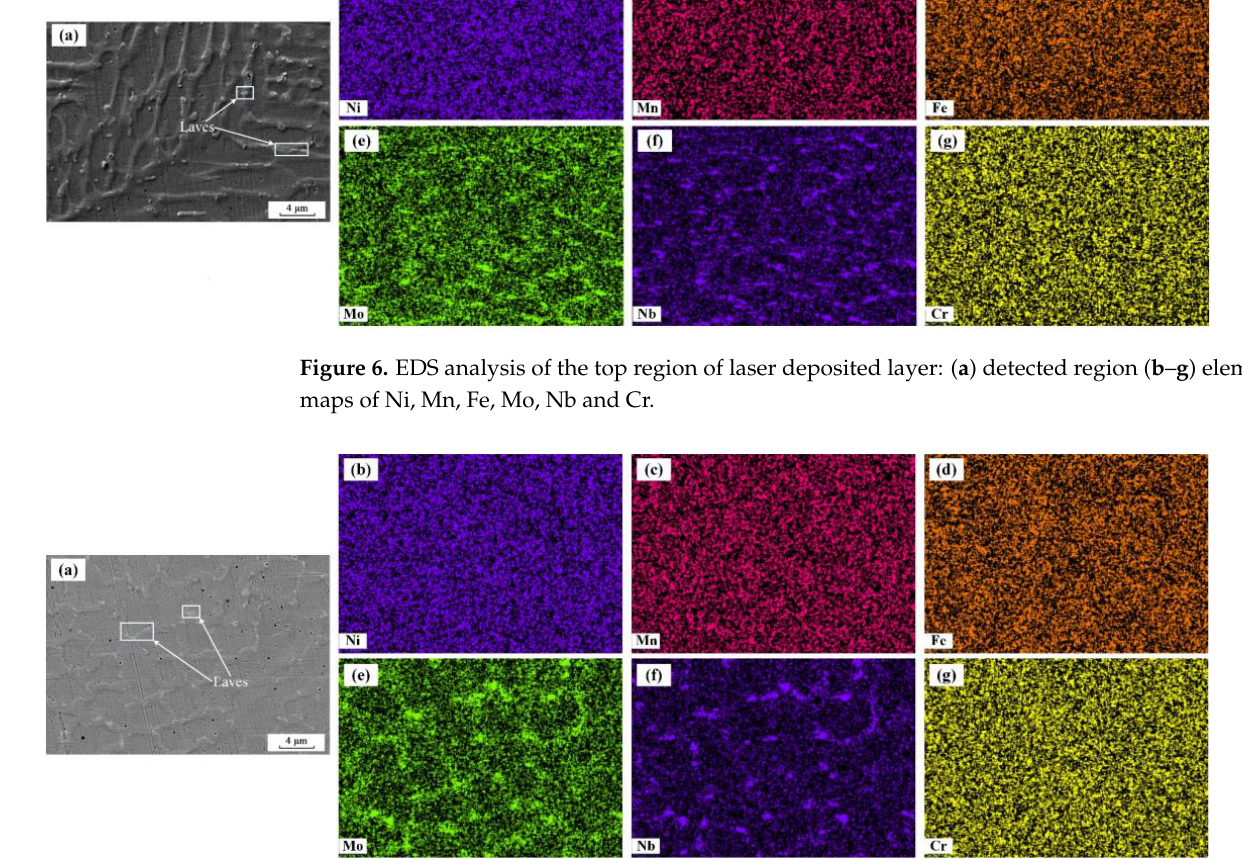
Figure 7. EDS analysis of the top region of laser-UHF induction hybrid deposited layer: ( a ) detected region ( b – e ) element maps of Ni, Mn, Fe, Mo, Nb and Cr.